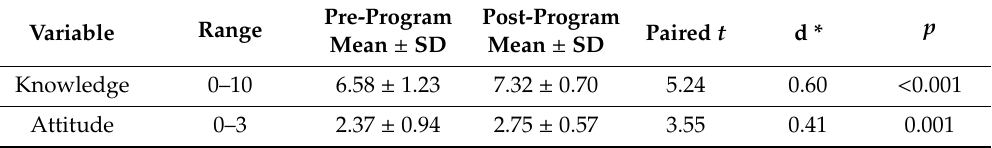
Table 3. Changes in oral hygiene knowledge and attitudes (N = 80).